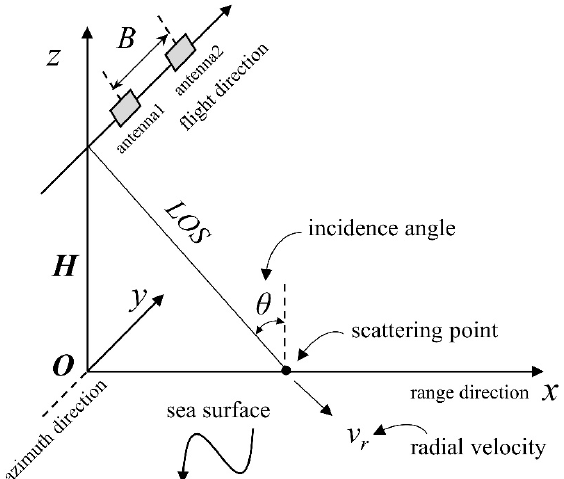
Figure 3. The ATI SAR system. Point O is the sub-satellite point and is taken as the origin of the system. The radar flight direction is taken as the positive x axis (range direction). The y axis is perpendicular to the radar flight direction on the horizontal plane (azimuth direction), and the trajectory from O to the measured point indicates the direction of the positive y axis. The z axis is perpendicular to sea level, and the trajectory from O to the satellite indicates the direction of the positive z axis. The platform height is H . The angle of incidence is θ The phase difference, Δφ , can be derived as follows: